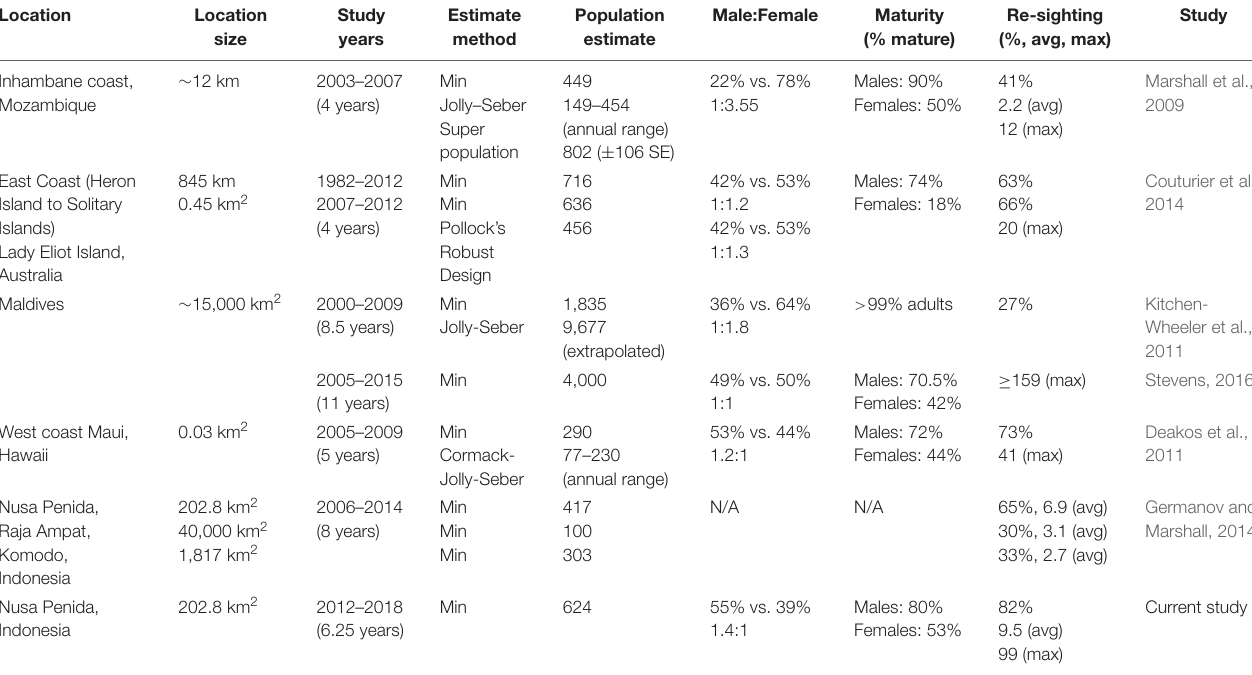
TABLE 3 | A comparison of manta ray ( M. alfredi ) population studies and demographics from the available literature. Location Location Study Estimate size years